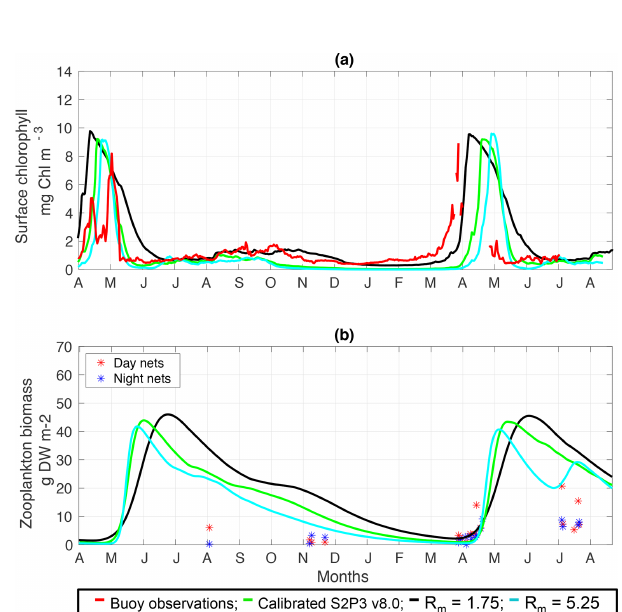
Figure C1. (a) SSB observations of surface chlorophyll a (red line), along with the modelled surface chlorophyll a for the calibrated S2P3 v8.0 model (green line), and experiments R max = 1 . 75 (black line) and R max = 5 . 25 (cyan line). (b) Observations of zooplank- ton biomass presented as discrete points for day nets (red dots) and night nets (blue dots) taken during the cruises DY026, DY018, DY029, and DY033; modelled zooplankton biomass from the cali- brated S2P3 v8.0 model (green line) and experiments R max = 1 . 75 (black line) and R max = 5 . 25 (cyan line).